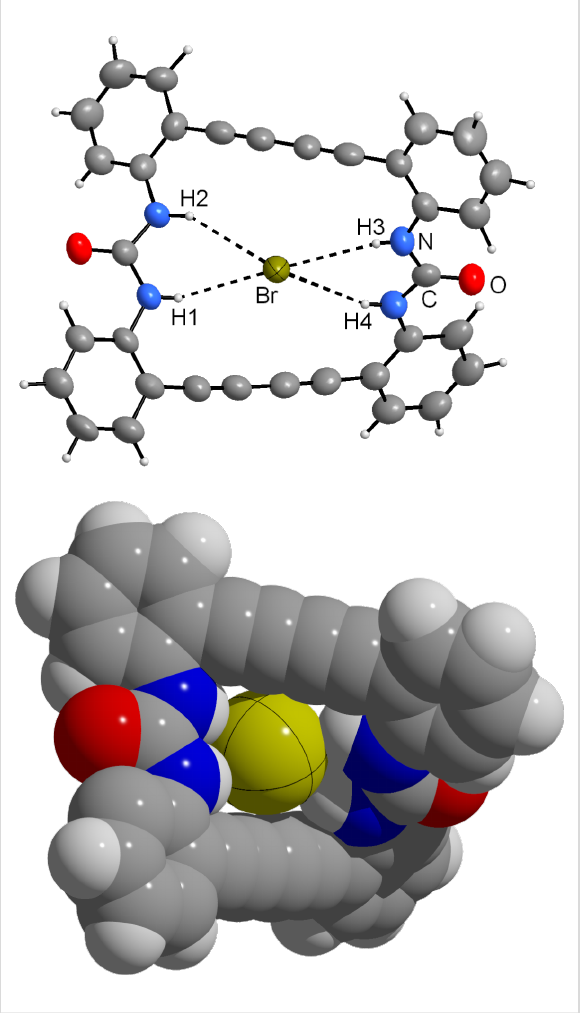
Figure 2: Molecular structure of the anionic complex in NEt 4 [Br· 2 ]. Two different representations are given, on top with thermal ellipsoids scaled at the 50% probability level, on bottom in a space filling repre- sentation showing the strong twist of the macrocyclic bis(urea) ligand.